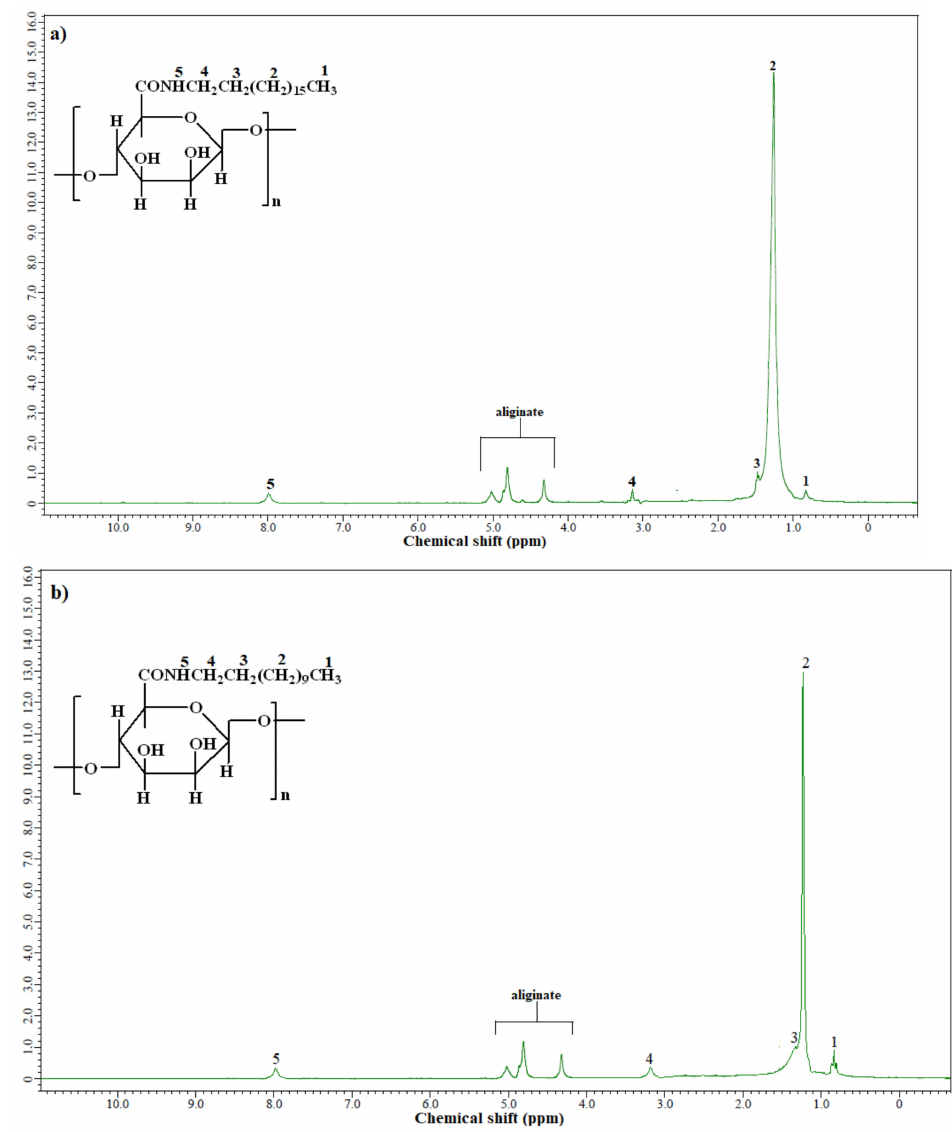
Figure 1. 1 H-NMR spectroscopies of ( a ) OA-ALG and ( b ) DA-ALG. The thermal stability of OA-MNPs and DA-MNPs was evaluated using TGA as presented in Figure 4. The data showed that the main decomposition occurred between 100 and 540 ◦ C. The initial weight loss with an increase of temperature up to 200 ◦ C is ascribed to the removal of physisorbed water and other solvents during the synthesis and purification steps of MNPs. However, the degradation in the region 200–540 ◦ C could be ascribed to the decomposition of DA-ALG, OA-ALG constituents. Additionally, the data also exhibited a larger increase in the magnetite content of DA-MNPs (70.17%) than that of OA-MNPs